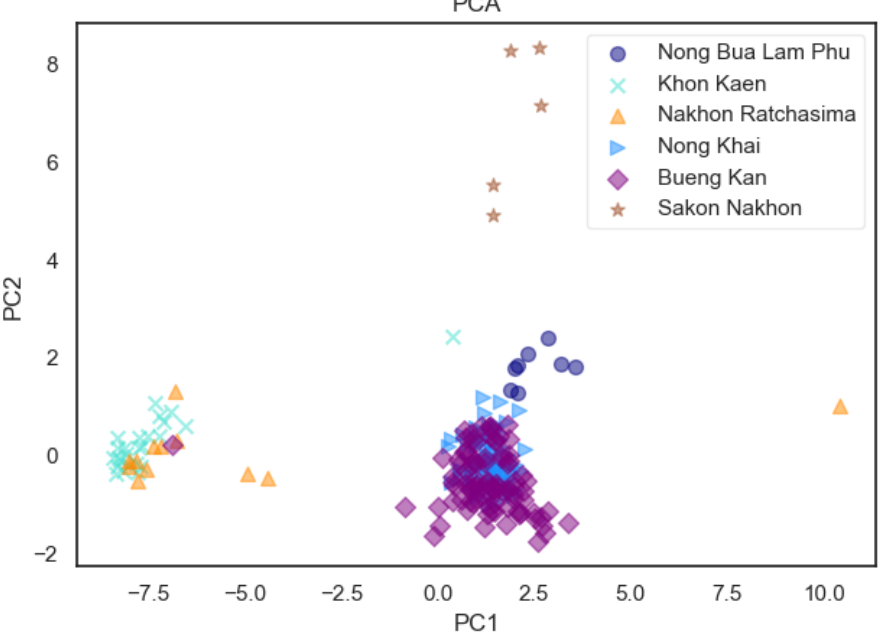
Figure 5. Grouping of the sand sample from six provinces (excluding Loei) using the activity concentrations of Ra-226, Th-232, K-40 and the annual indoor effective dose levels using principal component analysis.